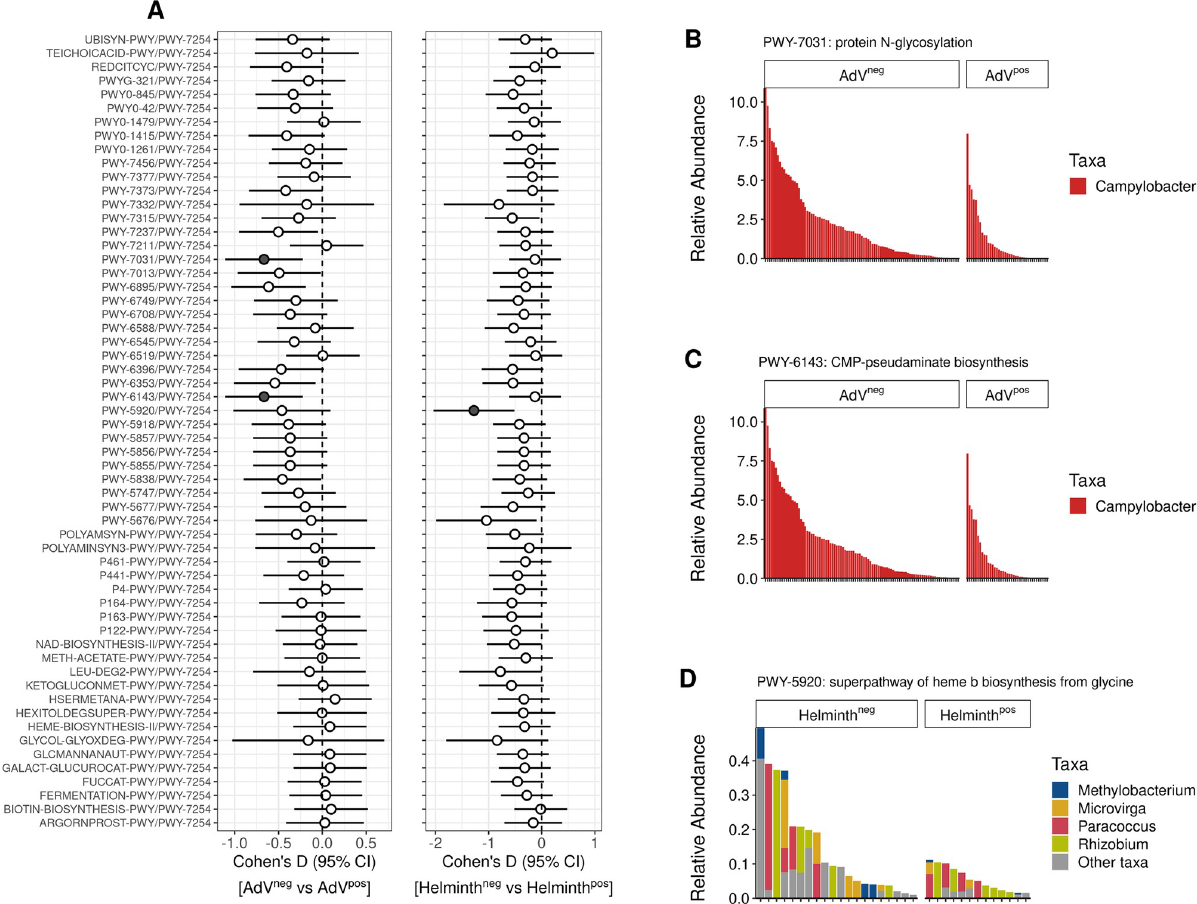
Fig 7. Differences in relative abundance of functional pathways associated with MHC diversity according to AdV and helminth infection. (A) Effect size (Cohen’s D and CI) forest plots of the log-ratios of the functional pathways associated to MHC motifs and to MHC functional diversity with respect to AdV and helminth infection. The pathway PWY-7254 was used as a reference frame to calculate the log-ratios. Filled symbols represent log- ratios with medium to large effect sizes (|Cohen’s D| > 0.50). (B-D) Contribution of bacterial taxa to pathways with medium-large effect sizes according to AdV or helminth infection. Stacked bar plots indicate the relative abundance of taxa across